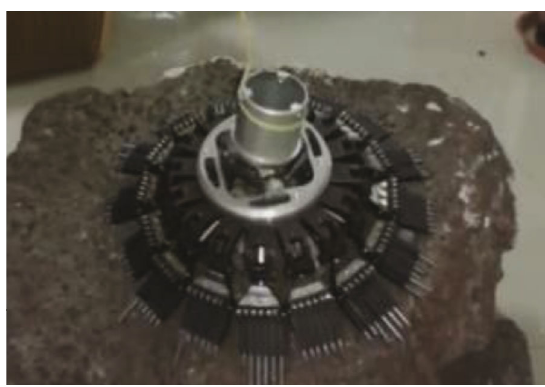
Figure 11: Anchoring experiment on the volcanic rock.